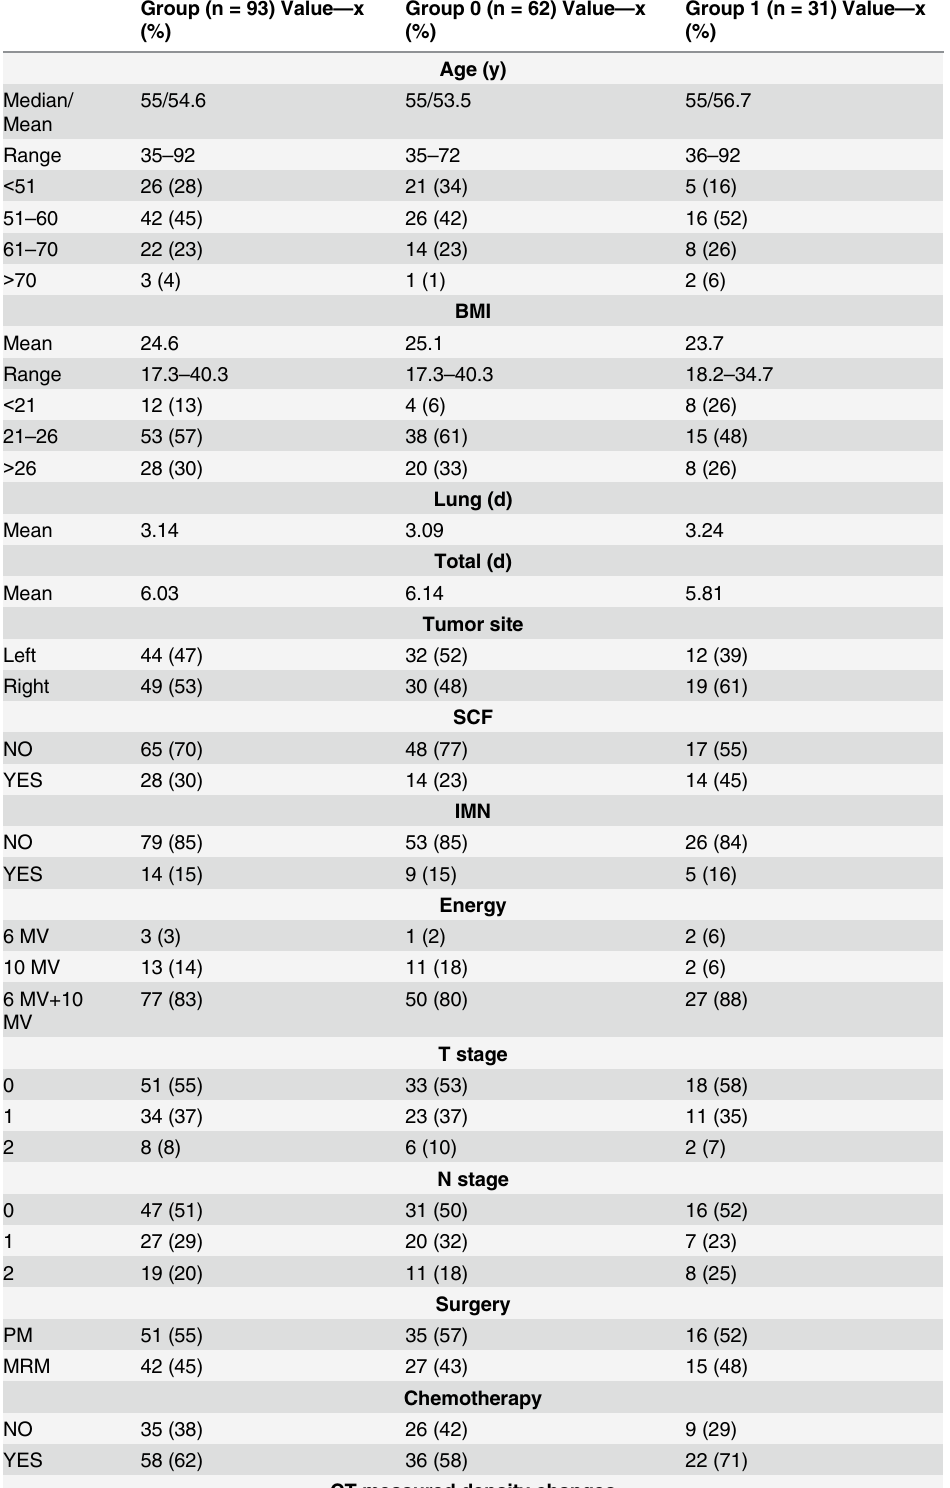
Table 1. Characteristics of